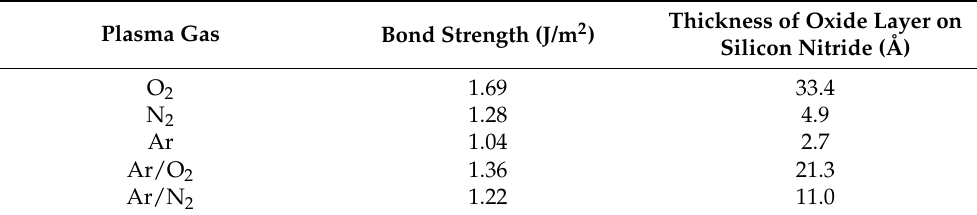
Table 1. Bond strength and the thickness of the oxide layer under various plasma gas conditions.